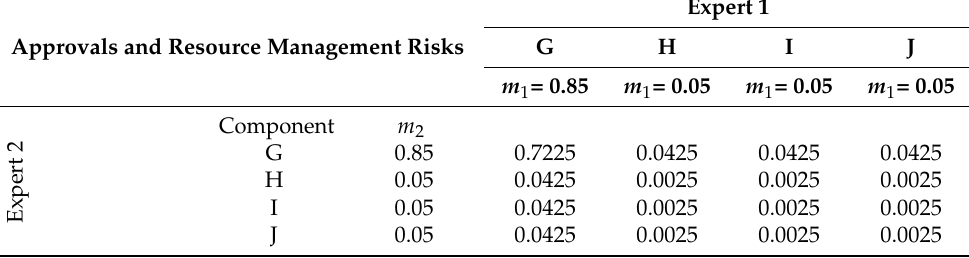
Table 10. Dempster combination of Expert 1 and Expert 2 for approvals and resource manage- ment risk.